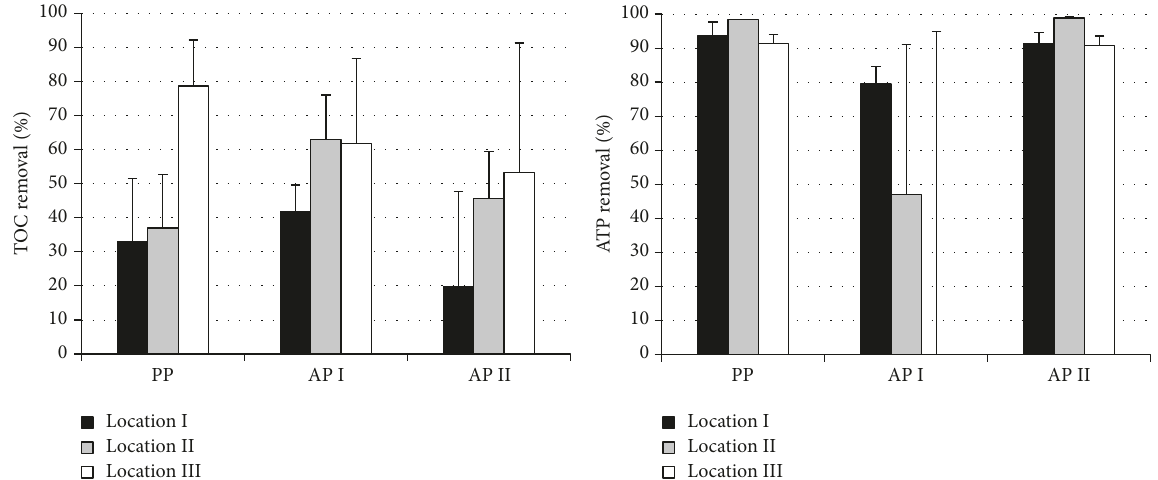
Figure 8: TOC and ATP removal after standard plant cleaning procedure (PP) and two adapted cleaning procedures (AP I and AP II) for membrane and spacer samples from locations I, II, and III. Chemical cleaning of full-scale fouled membrane elements was performed in laboratory test cell; error bars represent standard deviation (𝑛 = 2) .